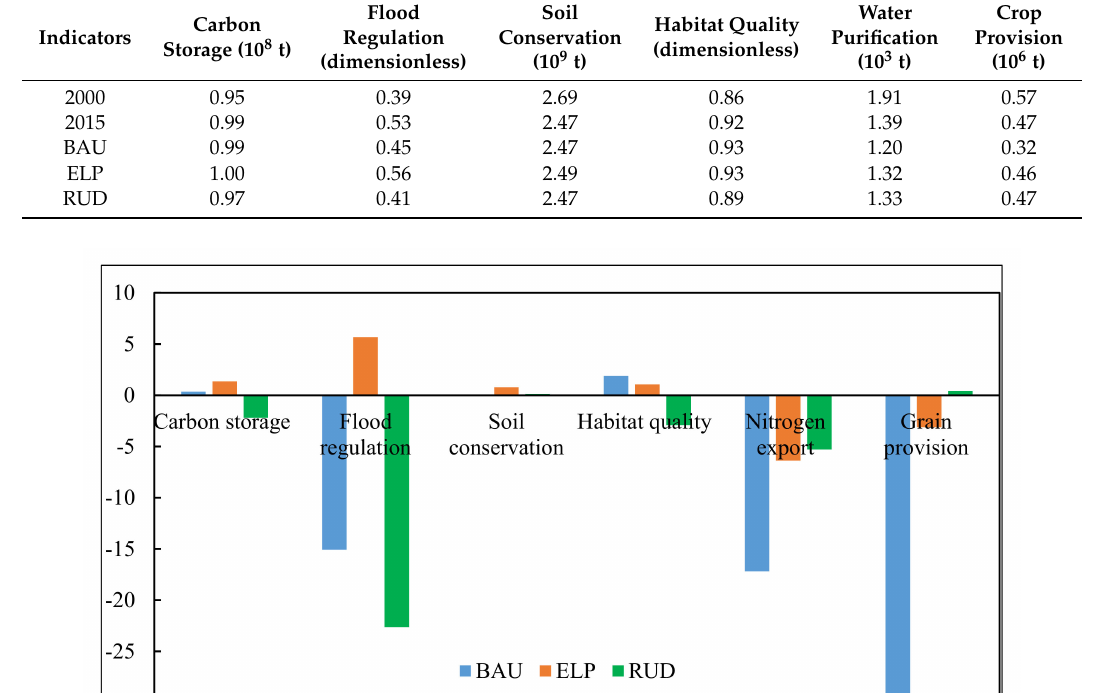
Table 4. The supply of multiple ecosystem service (ES) from 2000 to 2015 and the projected ES from 2015 to 2030 under three di ff erent scenarios.